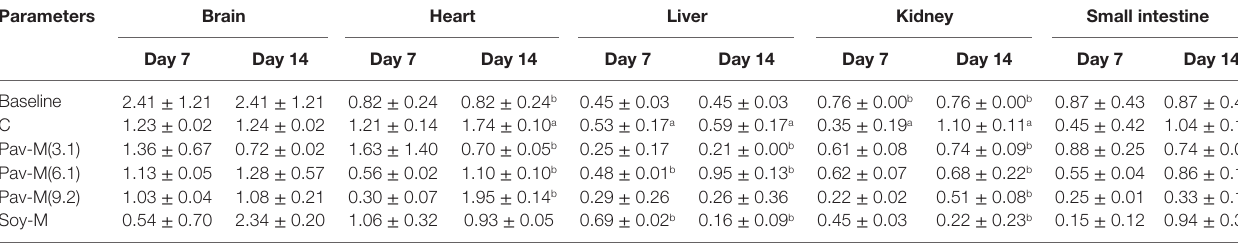
Value = mean ± SD (n = 3). Data within each column with different superscript alphabets are statistically different (P < 0.05). C, control; Pav-M(3.1), group with daily administration of 3.1 µl/g animal wt. pro-milk extract from A. pavonina seed; Pav-M(6.1), group with daily administration of 6.1 µl/g animal wt. pro-milk extract from A. pavonina seed; Pav-M(9.2), group with daily administration of 9.2 µl/g animal wt. pro-milk extract from A. pavonina seed; Soy-M, group with daily